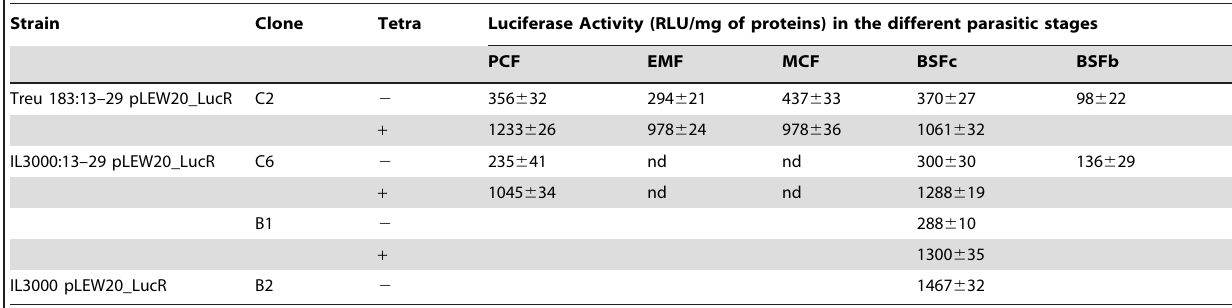
Strain Clone Tetra Luciferase Activity (RLU/mg of proteins) in the different parasitic stages